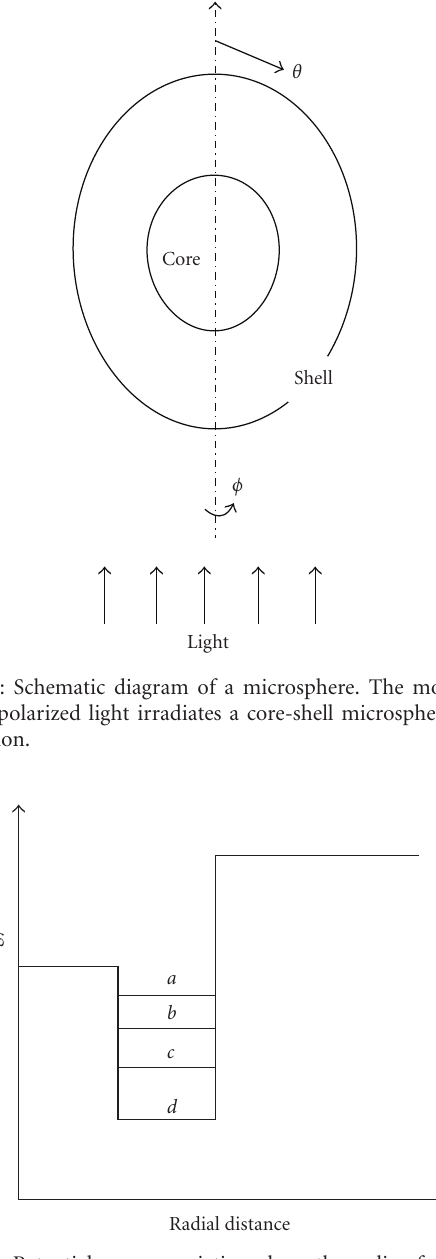
where k is the wave number, k = ω ( (cid:2) μ ) 1 / 2 , (cid:2) is the complex permittivity, and μ is the